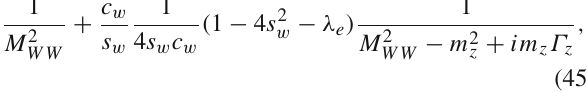
almost identical since their branching kernels only differ in the gauge boson mass and a factor of 1 / c w in the